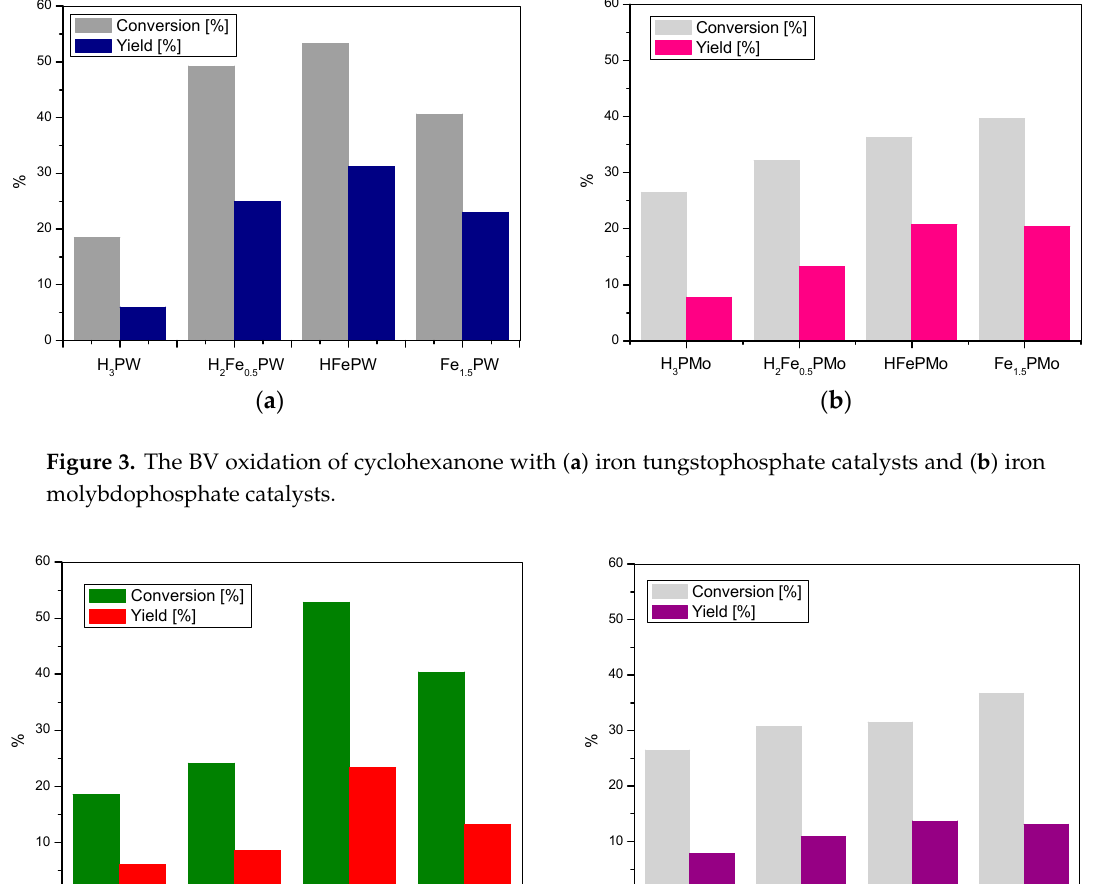
Figure 4. The BV oxidation of cyclohexanone with ( a ) manganese tungstophosphate catalysts and ( b ) manganese molybdophosphate catalysts.